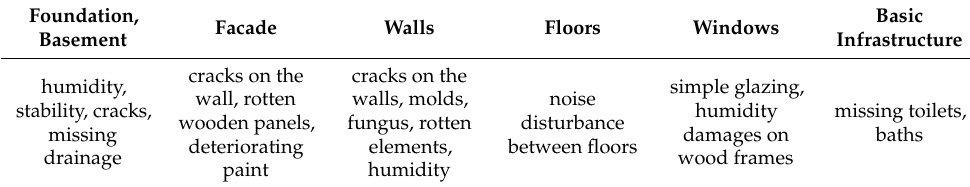
Table 2. Problems of the building stock based on site-observation.